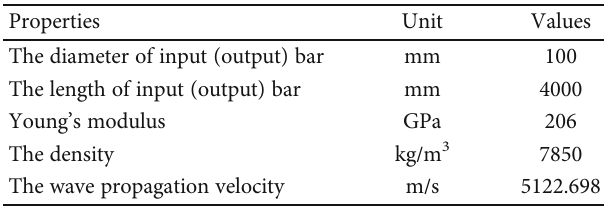
Table 4: Physical and mechanical properties of